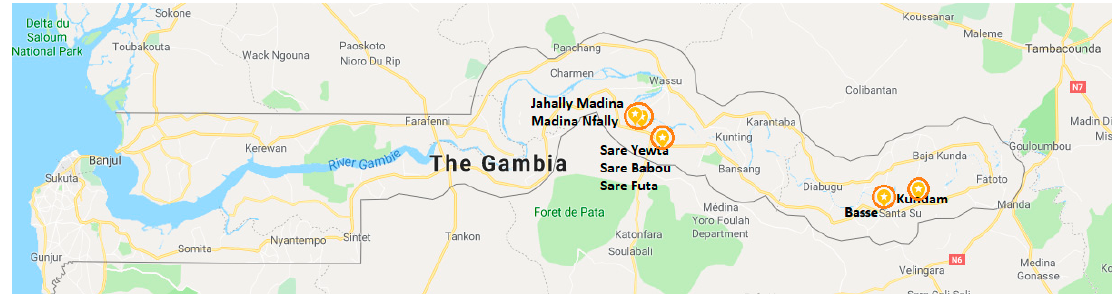
Figure 2. The areas of The Gambia where field work has been carried out.